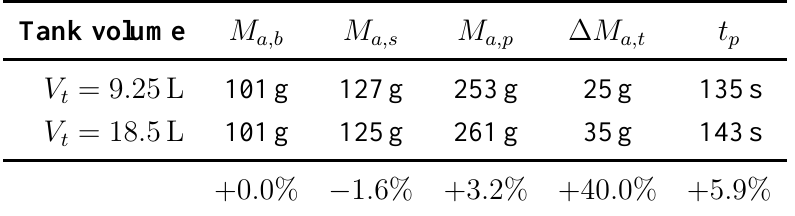
Table 4. Cumulative air masses transferred in each mode on the aNEDC for two different tank